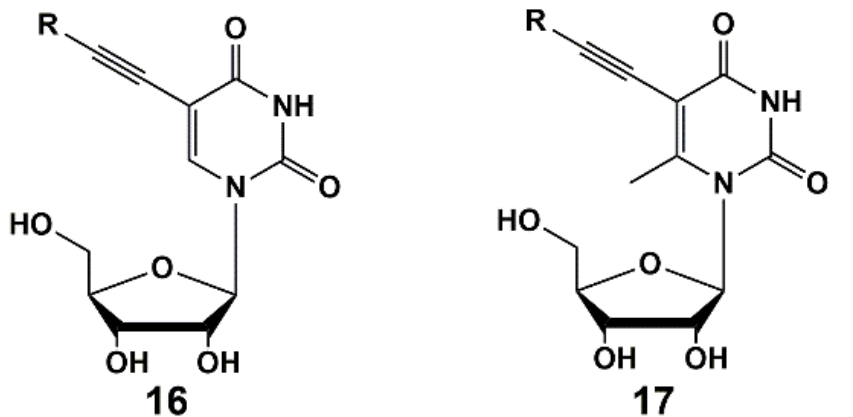
Figure 4. С -5 alkynyl derivatives of uridine and 6-methyluridine. Figure 4. C-5 alkynyl derivatives of uridine and